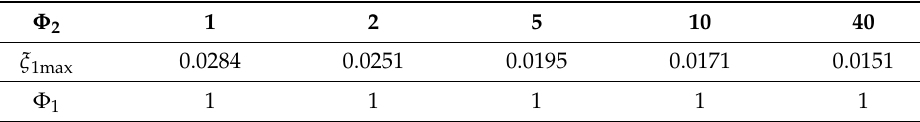
Table 3. Maximum damping ratio ξ 1max for each Φ 2.